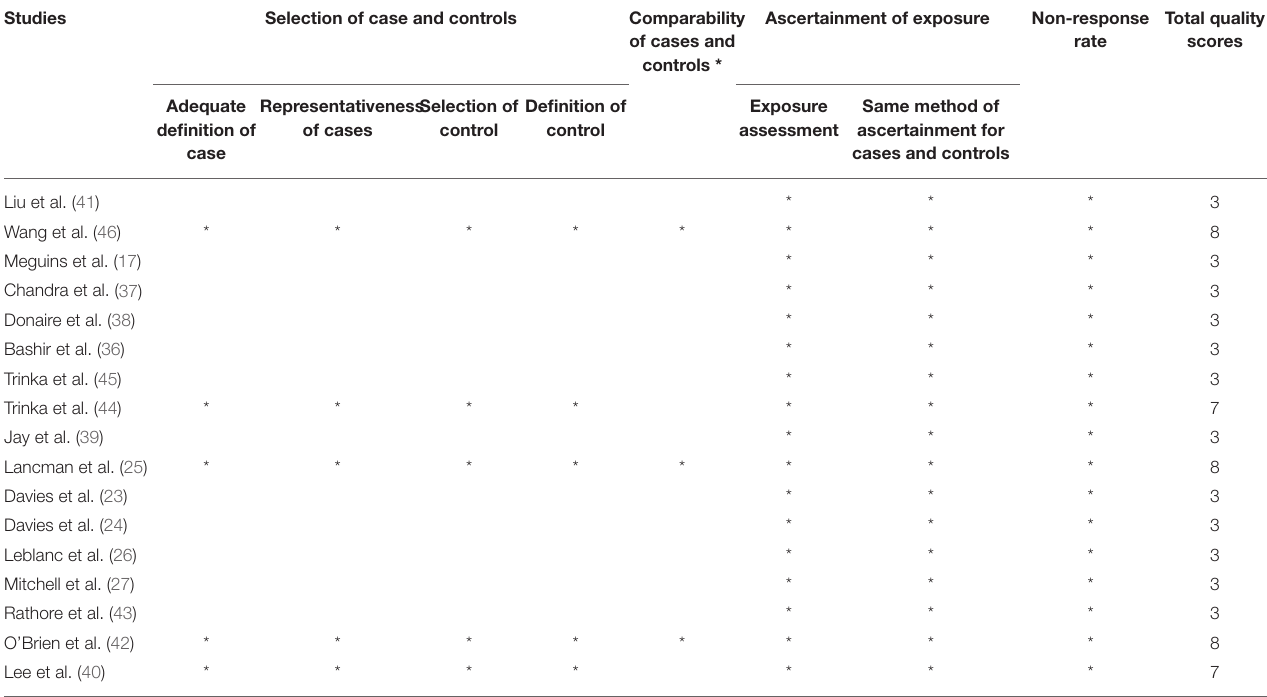
TABLE 2 | Quality of the included